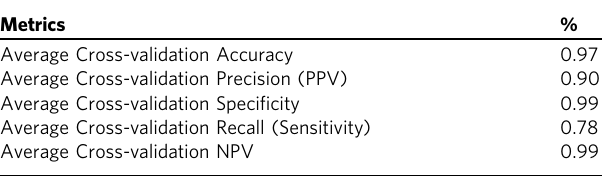
Table 2 Evaluation of the ROI detection using 5-fold cross- validation to calculate accuracy, precision (PPV-Positive Predictive Value), recall (Sensitivity), speci fi city, and NPV (Negative Predictive